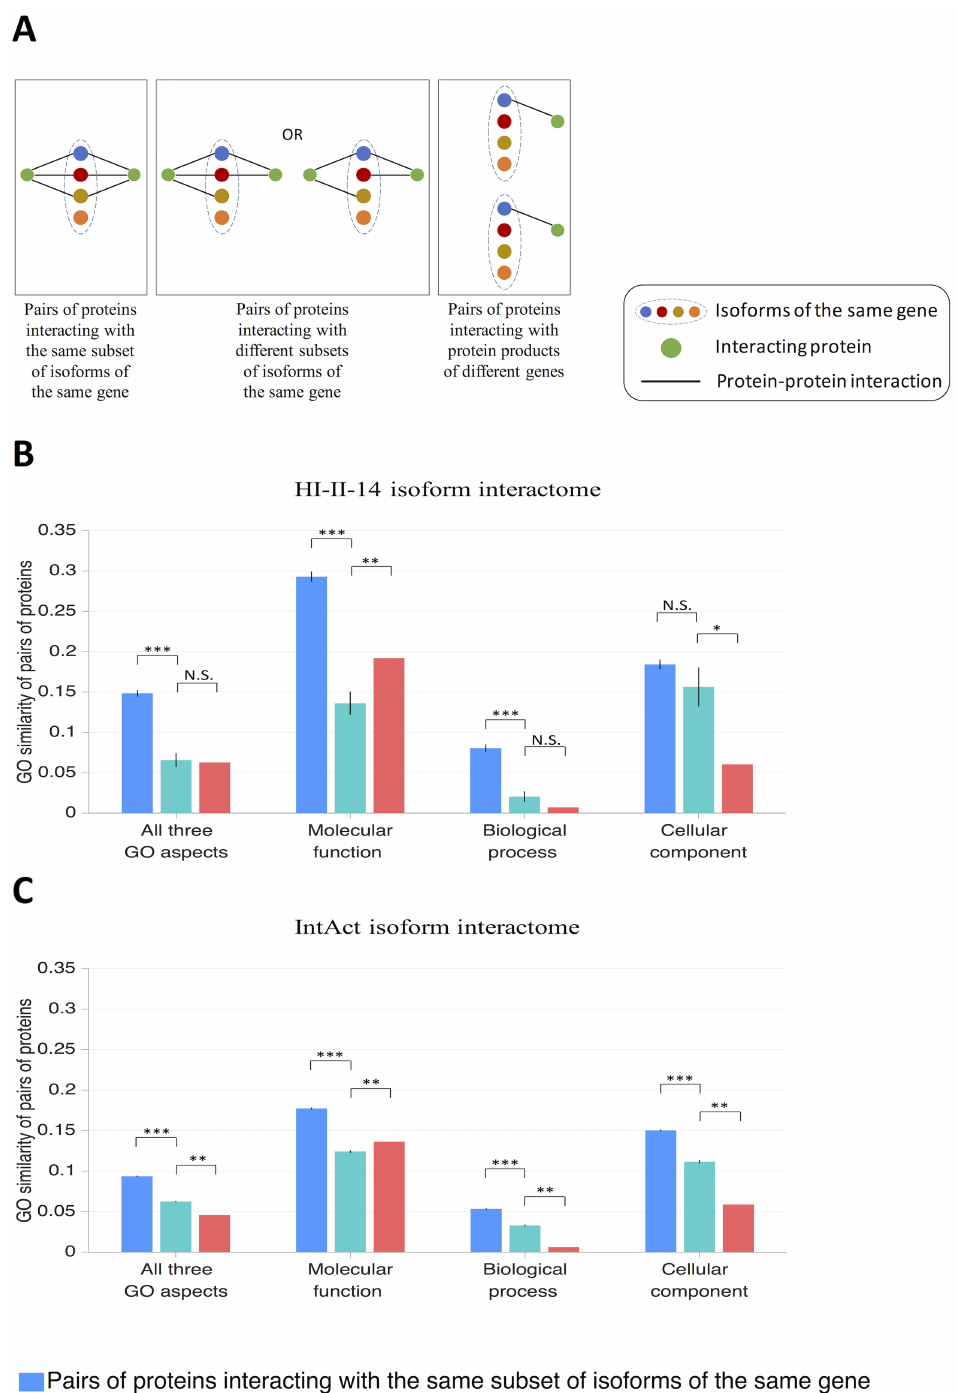
Fig 2. Gene Ontology (GO) similarity for protein pairs with different types of isoform interaction profiles. (A) Schematic diagram illustrating different types of isoform interaction profiles for a pair of proteins. (B) GO similarity for pairs of proteinsinteractingwith the same subset of isoforms of the same gene, with different subsets of isoforms of the same gene, and with protein products of different genes in the predicted HI-II-14 isoform interactome. (C) GO similarity for pairs of proteins interacting with the same subset of